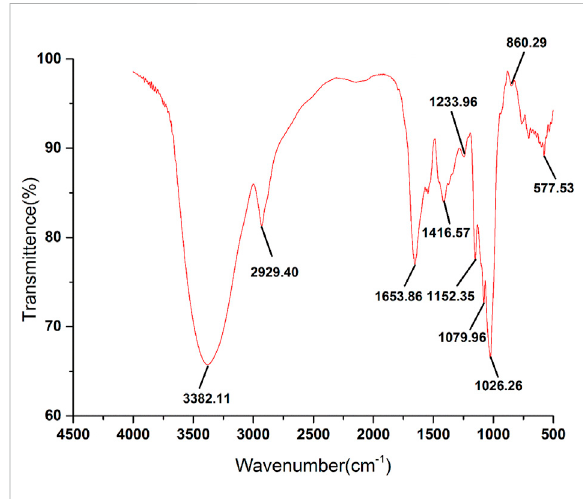
FIGURE 6 FT-IR spectra of RFP. RFP has a signi fi cant polysaccharide pro fi le and β -pyranose conformation.